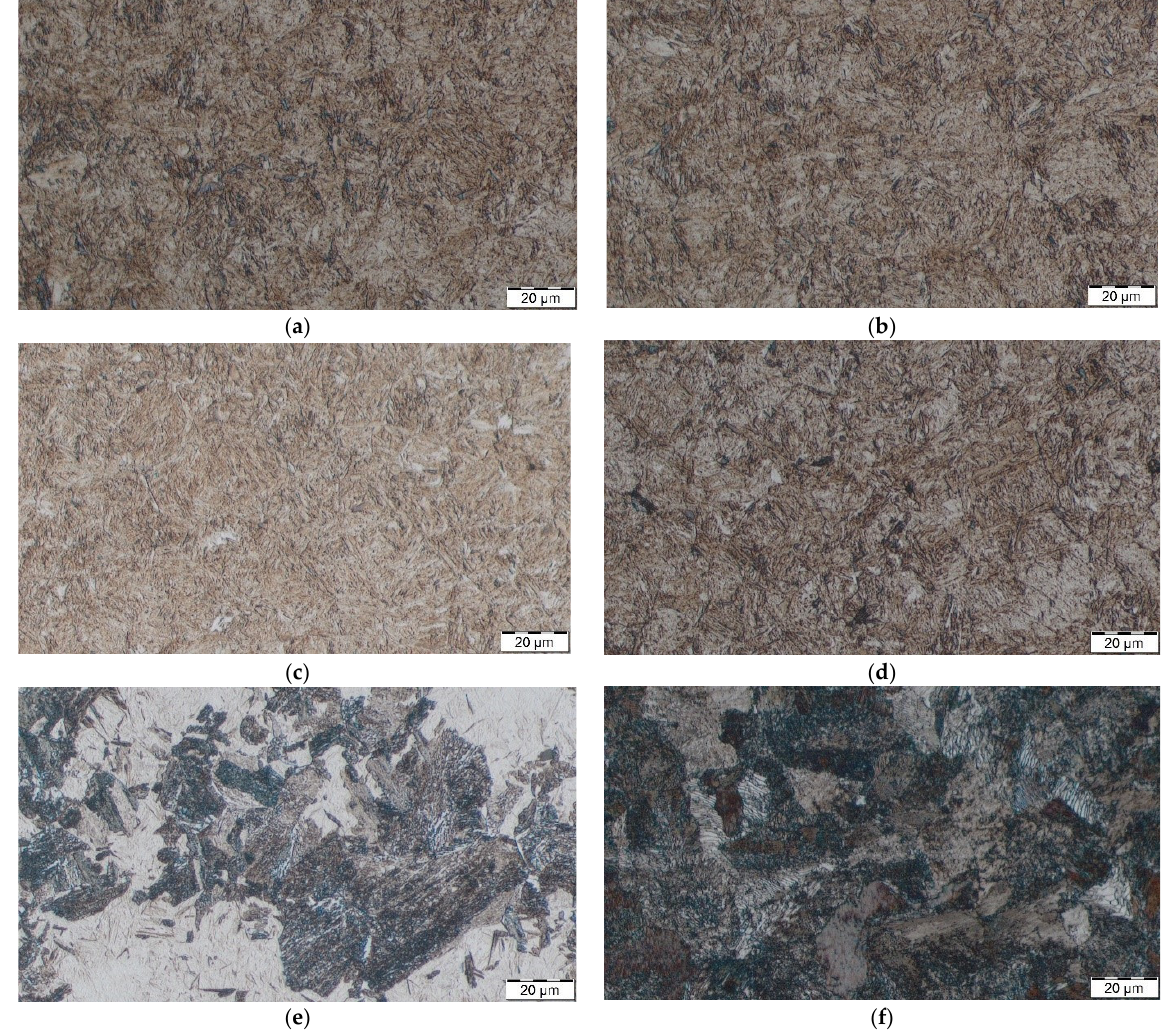
Figure 5. Optical micrographs of 55Cr3 cooled at ( a ) 100 °C/s, ( b ) 30 °C/s, ( c ) 20 °C/s, ( d ) 10 °C/s, ( e ) 1 °C/s, and ( f ) 0.1 °C/s.